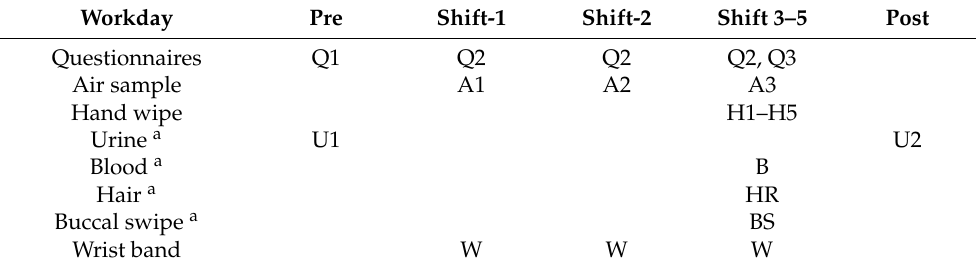
Table 5. Times and days of sample and data collection for a participant from the exposed